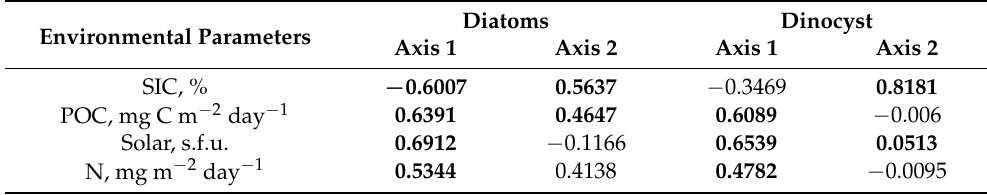
Table 2. Coefficient of correlation between environmental parameters and the scores of the two first axes of redundancy analysis. Parameter abbreviations are shown below Figure 10. Bold numbers correspond to parameters which are best correlated to